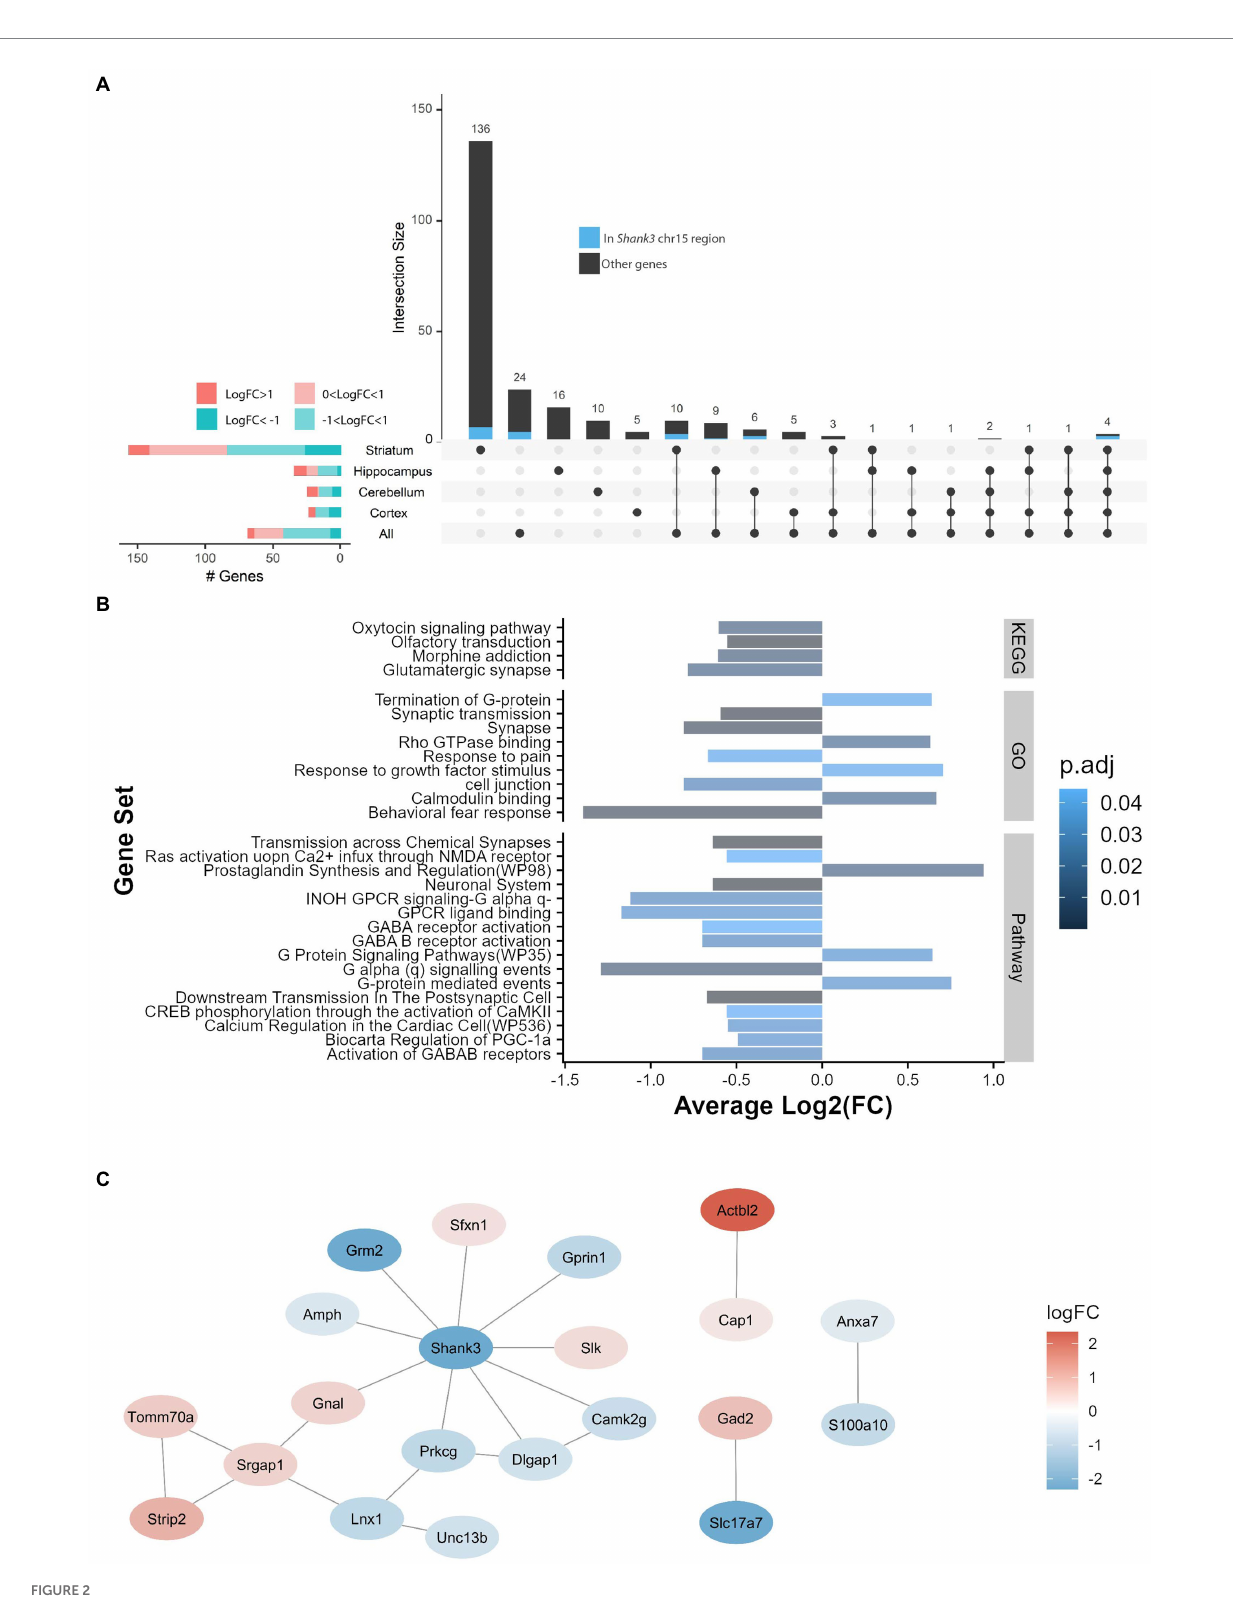
FIGURE 2 The striatum displays the largest gene expression differences between Shank3 +/+ and Shank3 Δ 11/ Δ 11 mice and the largest number of impacted pathways. (A) Upset plot displaying the intersection between brain structures for the genes differentially expressed between Shank3 Δ 11/ Δ 11 and Shank3 +/+ mice (adjusted value of p < 0.05; determined by limma-voom using observation quality weights). Genes located around the Shank3 region on chromosome 15 are shown in blue. The horizontal bar plots on the left show the number of differentially expressed genes in the different brain structures according to the value of their log-fold changes (logFC). (B) GO (Gene Ontology), GeneSetDB Pathway (gsdbpath), and KEGG (Kyoto Encyclopaedia of Genes and Genomes) gene sets found to be over-represented (top 20 gene sets with adjusted value of p < 0.05) in the genes detected as differentially expressed in the striatum. (C) Protein–protein interaction (PPI) network for the differentially expressed genes (DEGs). Nodes, colored ovals, represent DEGs; edges, black lines, represent direct protein–protein interactions (from BioGrid) between DEGs products. The color of the node represents the Log2FC of DEGs: red means up-regulation and blue means down-regulation in Shank3 Δ 11/ Δ 11 mice compared to wild-type